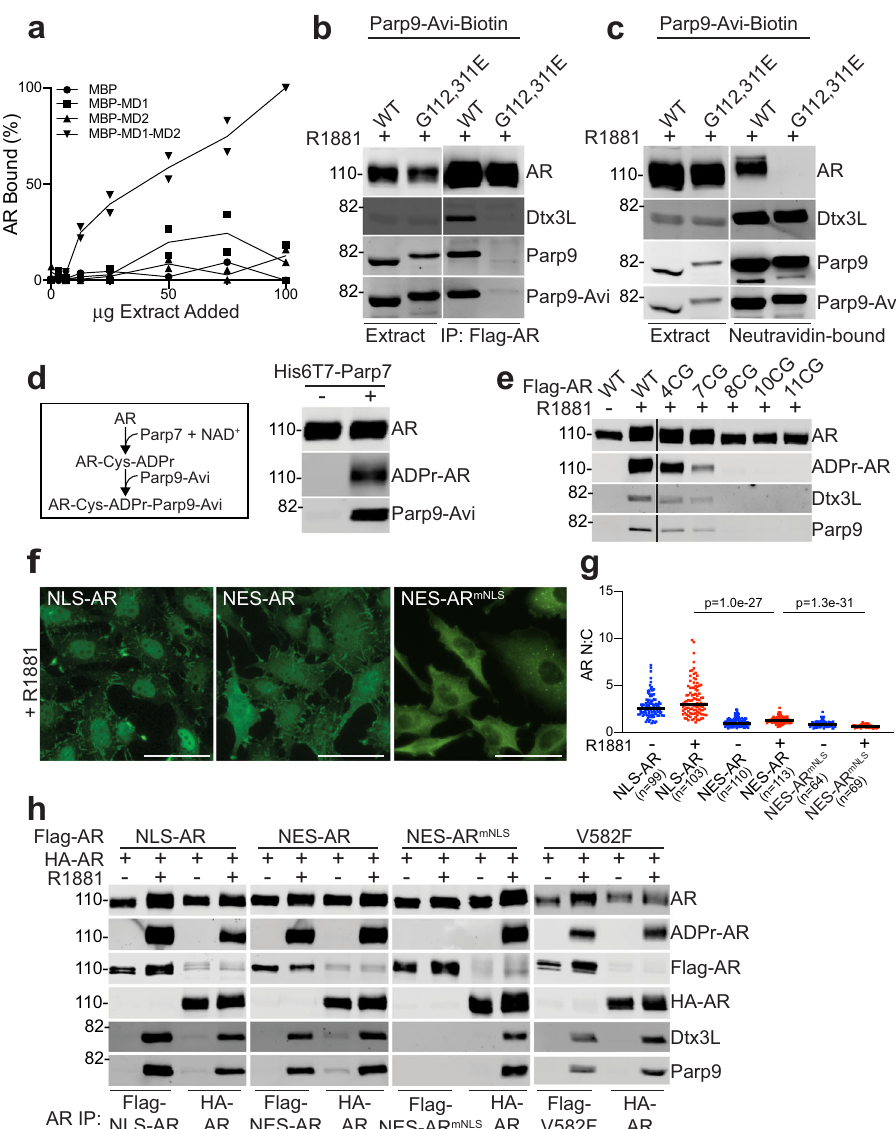
Fig. 4 Parp9 macrodomains are readers of AR cysteine ADP-ribosylation. a AR binding to Parp9 MDs immobilized on maltose beads as a function of cell extract concentration (from R1881-treated PC3-AR cells; Supplementary Fig. 18a). Shown are the levels of AR binding to MBP ( fi lled circle), MBP-MD1 ( fi lled square), MBP-MD2 ( fi lled triangle), and MBP-MD1-MD2 (inverted fi lled triangle). b Point mutations in the Parp9 MDs eliminate Dtx3L/Parp9 binding to ADP-ribosylated AR. Stable PC3-AR lines expressing GFP-BirA and C-terminal Avi-tagged WT Parp9 and mutant Parp9 (G112, 311E) were treated with R1881 and used to IP AR. Extracts and bound fractions were examined by immunoblotting for AR, Dtx3L, Parp9, and Parp9-Avi (scheme in Supplementary Fig. 18c). c Extracts prepared as described in panel b , and Neutravidin beads were used to recover WT and mutant (G112,311E) Parp9-Avi- biotin and associated proteins. The extracts and bound fractions were probed as in panel b . d ADP-ribosylation of AR by Parp7 in vitro generates Parp9 binding sites. AR immobilized on beads was incubated with NAD + + His-tagged Parp7. The beads were washed, combined with extract from Parp9-Avi expressing cells, washed, and the post-reaction bound fractions were probed for ADP-ribosylation and Parp9-Avi. e Biochemical analysis of AR ADP- ribosylation mutants. Flag-tagged AR Cys-to-Gly (CG) AR mutants (Supplementary Fig. 19a) were stably expressed in PC3M/HA-Parp7 cells and treated + R1881. AR IP ’ s were probed for AR, AR ADP-ribosylation, Dtx3L, and Parp9. f Localization of Flag-tagged AR transport signal fusions in PC3M cells by IF microscopy using M2 antibody. Scale bars = 20 microns. g Nuclear:cytoplasmic (N:C) ratios of Flag-tagged AR transport signal fusions in PC3M cells. N:C ratios ( − R1881, blue; + R1881, red; median, black line) were measured 39 and analyzed using an unpaired, two-tailed t test. h Biochemical analysis of AR transport signal fusions. PC3M cells co-expressing HA-WT AR and Flag-tagged AR with transport signal fusions were prepared as stable lines. HA-WT AR was also co-expressed stably with the DNA-binding domain mutant Flag-tagged AR V582F in PC3M cells (diagrammed in Supplementary Fig. 19b). Cells were treated + R1881 and the extracts were used to IP WT and mutant forms of AR. The IP ’ s were then probed for AR, ADP-ribosylation, Dtx3L, and Parp9. Source data are provided as a Source data fi